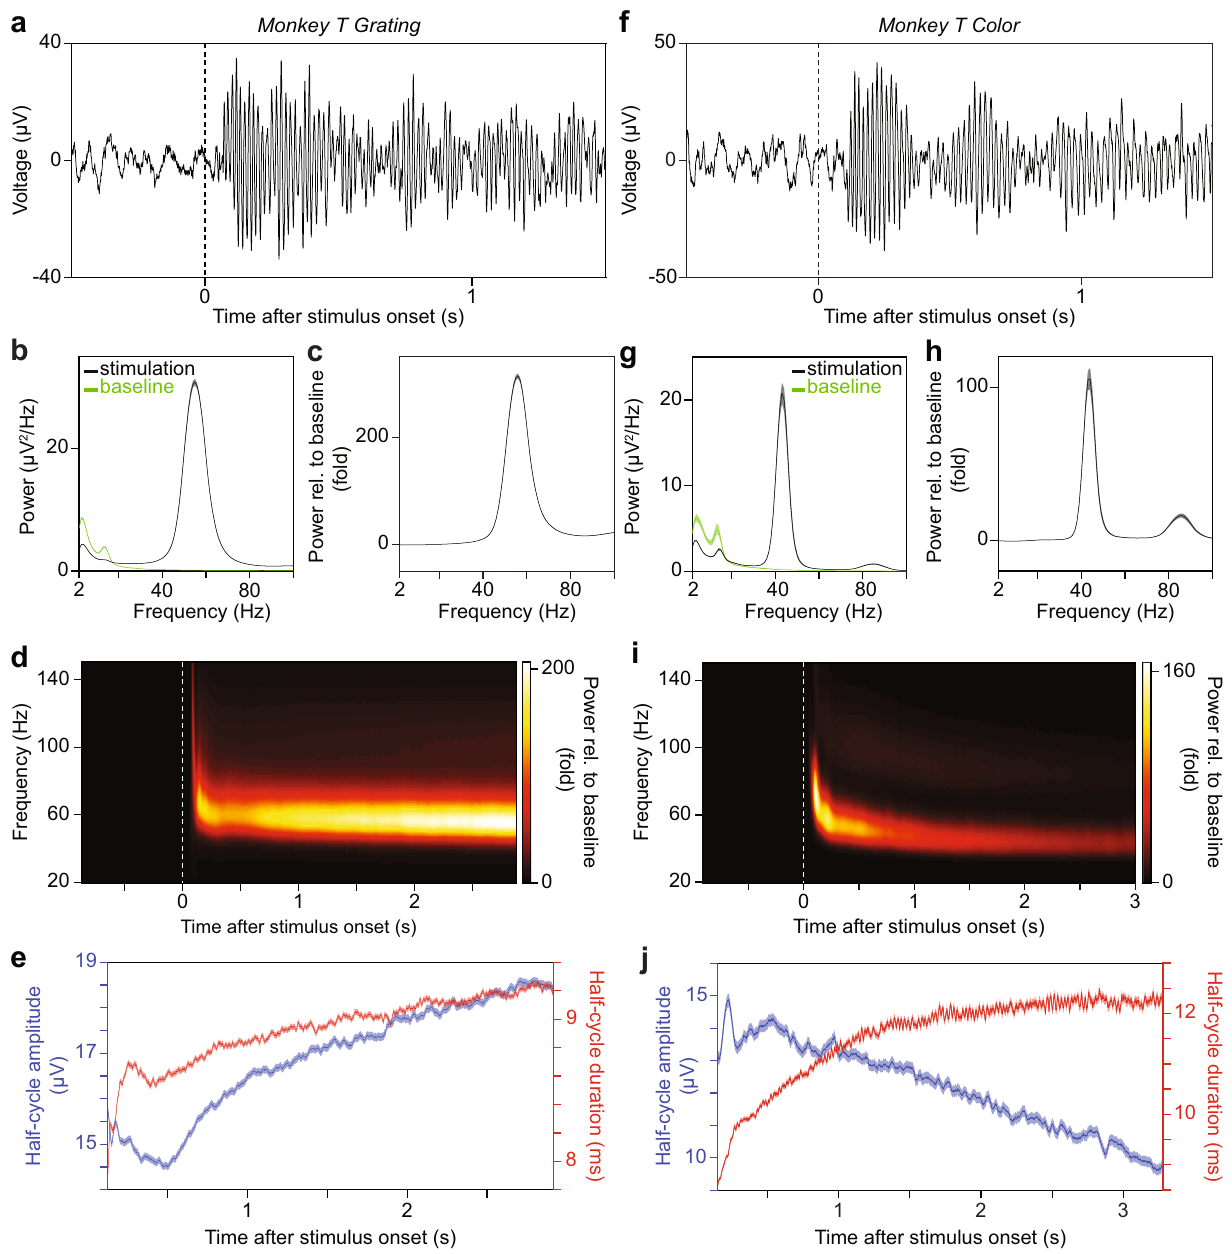
Fig. 1 Gamma dynamics in awake macaque V1 during visual stimulation. a Raw LFP trace from one representative recording site from area V1 in monkey T before and during the presentation of a full-screen drifting grating. b , c Raw power ( b ) and power-change relative to baseline ( c ), averaged across all selected recording sites from V1 in monkey T. The green and black traces in b correspond to the pre-stimulus baseline period and stimulation period respectively. The error regions show 2 standard errors of the mean (S.E.M.) based on a bootstrap procedure across trials (1000 bootstraps). d Power change relative to baseline, as function of frequency and time relative to stimulus onset, averaged over all selected V1 recording sites in monkey T before and during the presentation of a full-screen drifting grating. Note the changes in gamma amplitude and frequency with time after stimulus onset. e Time course of gamma-half-cycle amplitude (blue) and duration (red), averaged over all selected V1 recording sites in monkey T during the presentation of a full- screen drifting grating. The error regions show ±2 SEM based on a bootstrap procedure. Only the stimulation period is shown, because only very few gamma cycles of very low amplitude were detected before stimulus onset. f – j Same as a – e , but for the presentation of a full-screen uniform color surface. a , d , f , i Dashed lines indicate stimulus